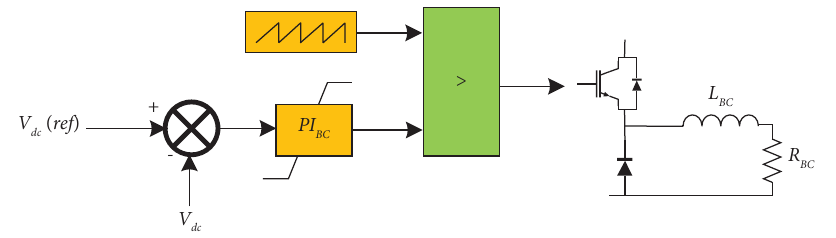
Figure 7: Connection of the BC unit to the DCL with its control system.